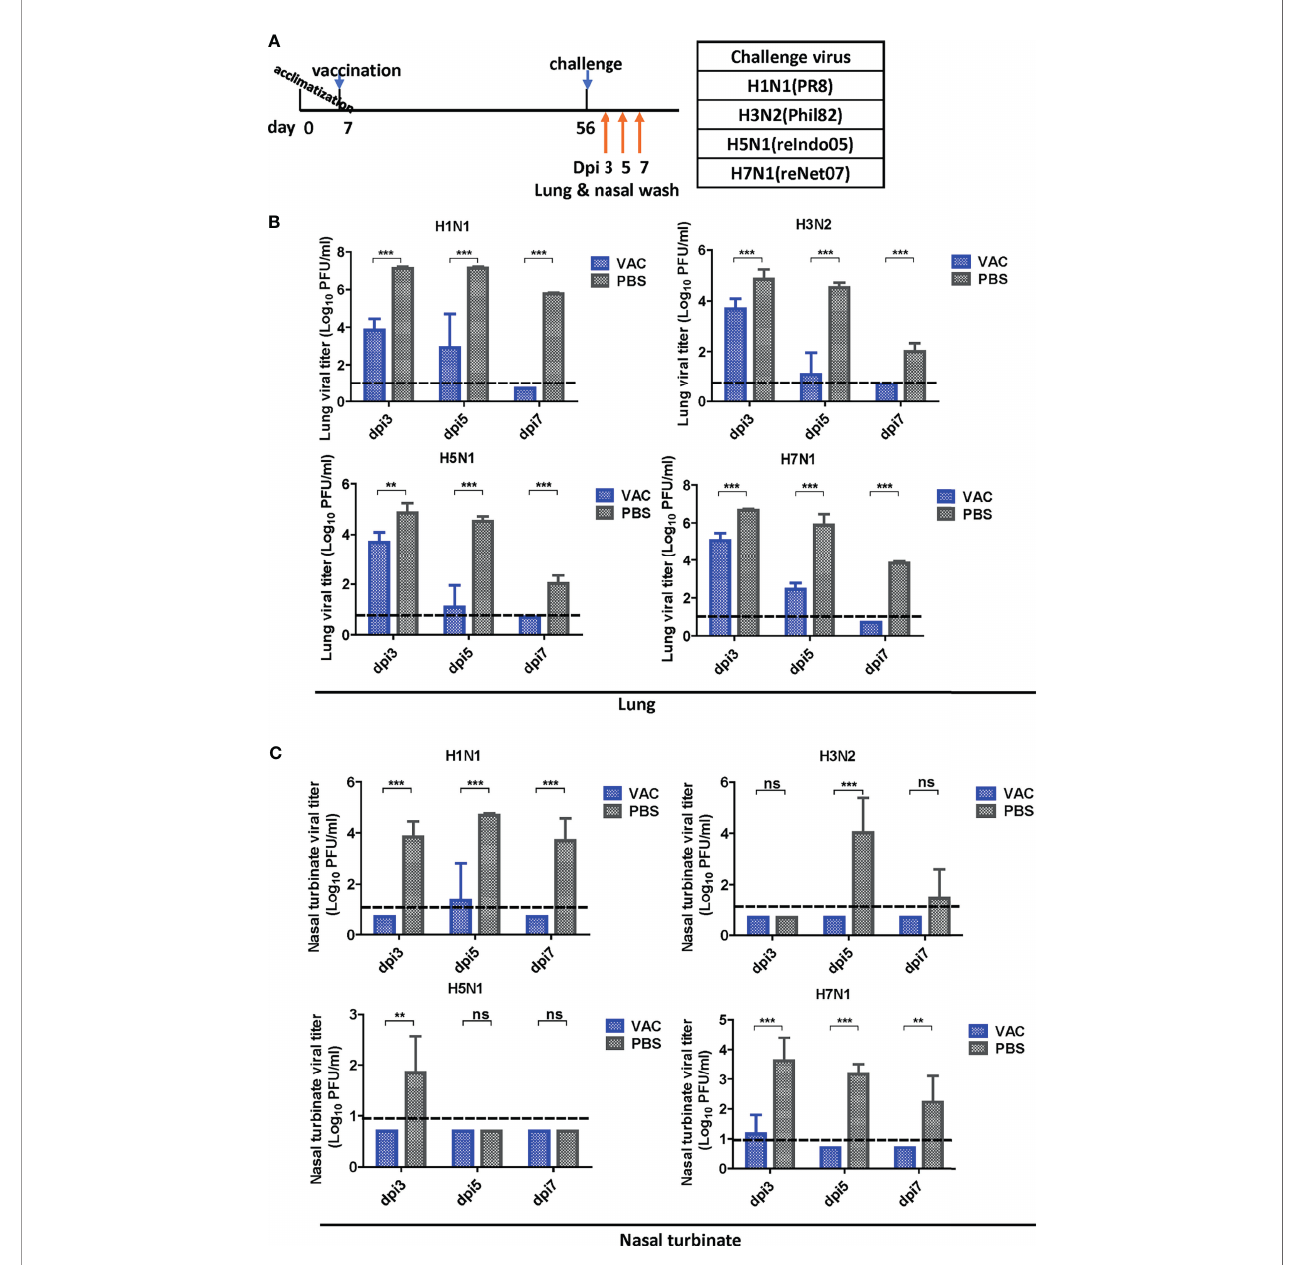
FIGURE 3 | Viral clearance in the respiratory tract after challenge. (A) Schematic diagram of the schedule of harvesting lung and nasal turbinate samples. Lungs and turbinate samples were harvested on days 3, 5, and 7 post-infection (dpi) to test the sterile immunity after challenge with four types of viruses. (B, C) Sterile immunity in the mouse lungs and turbinate samples against four types of in fl uenza A viruses challenge. The mice vaccinated with DM-C LAIV or PBS were sacri fi ced at 3, 5, and 7 dpi for collection of lungs (B) and turbinate samples (C) to titrate viruses by plaque assay. The detection limit was indicated by a dotted line in the graph. The graph shows the mean of each cohort (N=5) , and the error bar means the standard deviation (SD). Two-tailed t- test was performed for comparing the differences between DM-C LAIV-vaccinated and PBS-treated groups (***P < 0.001; **P < 0.01; ns means not signi fi (PR8) as coated antigen (27), high titers of IgG1 and IgG2a antibodies were detected at both weeks 4 and 6 ( Figure 5A ).